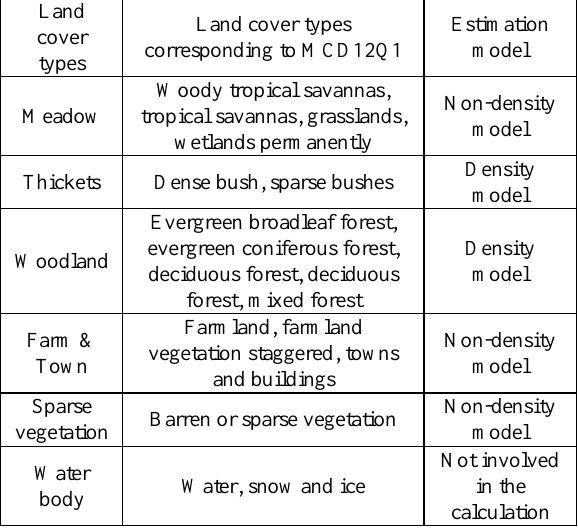
Table 1. Different land cover types and the vegetation